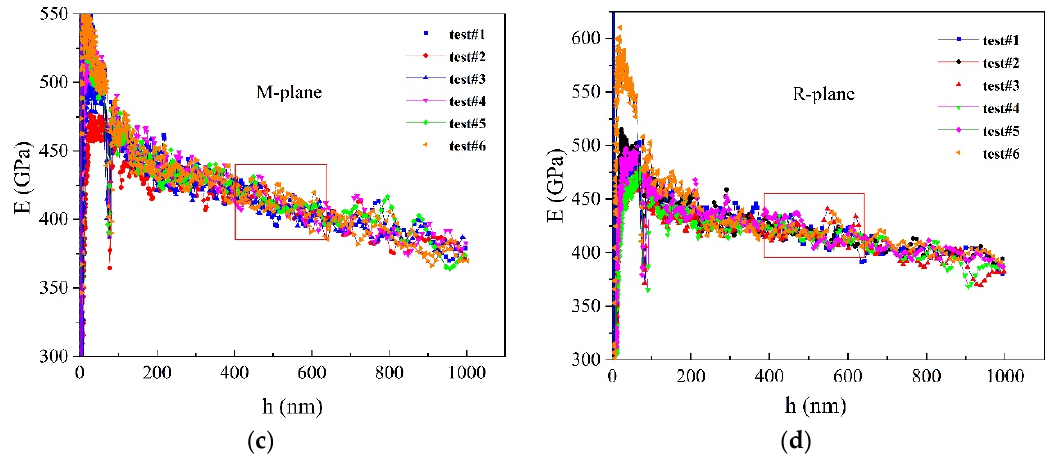
Figure 4. The elastic modulus as a function of the indentation depth of the four crystal orientations for the ( a ) A-plane, ( b ) C-plane, ( c ) M-plane and ( d ) R-plane.